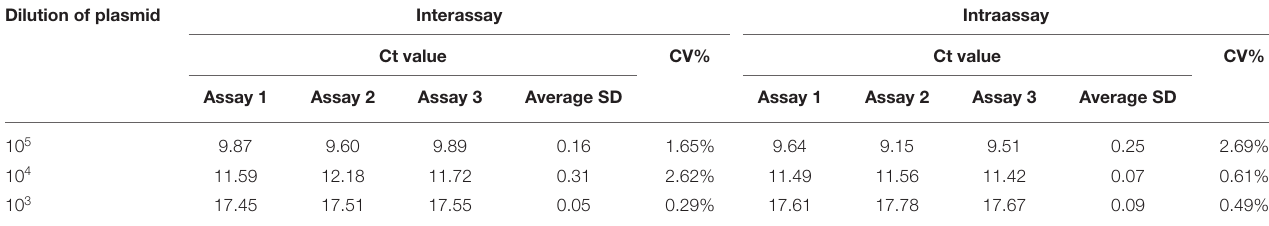
TABLE 3 | Intrareproducibility and interreproducibility assay. Dilution of